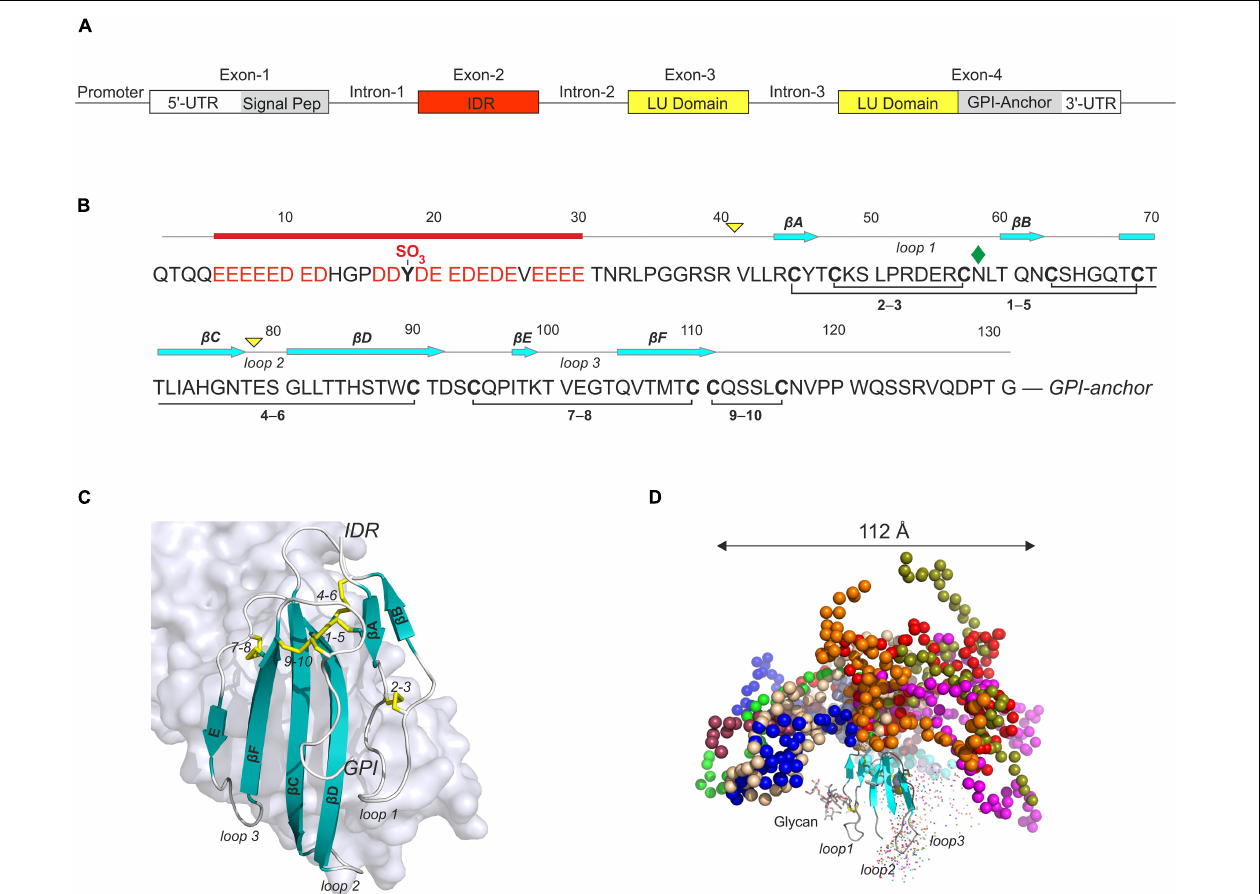
FIGURE 3 | GPIHBP1 is an atypical member of the LU-domain gene family. (A) The organization of human GPIHBP1 on chromosome 8q24. Unlike canonical members of the LU supergene family, which have three exons, GPIHBP1 has an extra exon (IDR, red box) encoding an intrinsically disordered acidic N-terminal extension. (B) This extension contains 21 acidic residues and one sulfated tyrosine in the first 30 residues of mature GPIHBP1 1 - 131 (Kristensen et al., 2018) and it is denoted GPIHBP1’s acidic domain. Mature GPIHBP1 1 - 131 contains a disordered acidic domain followed by a canonical folded LU domain harboring five